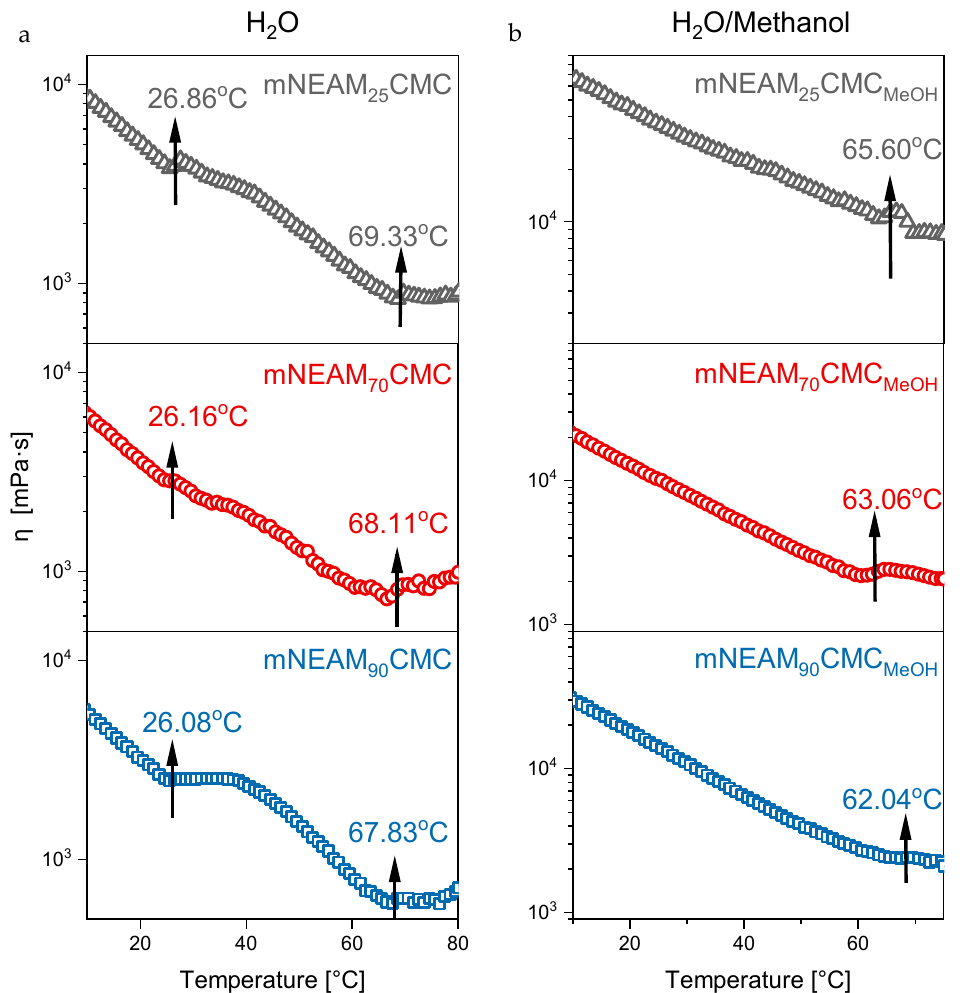
Figure 3. Complex viscosities as a function of the temperature of blends prepared in water ( a ) and water/methanol ( b ).